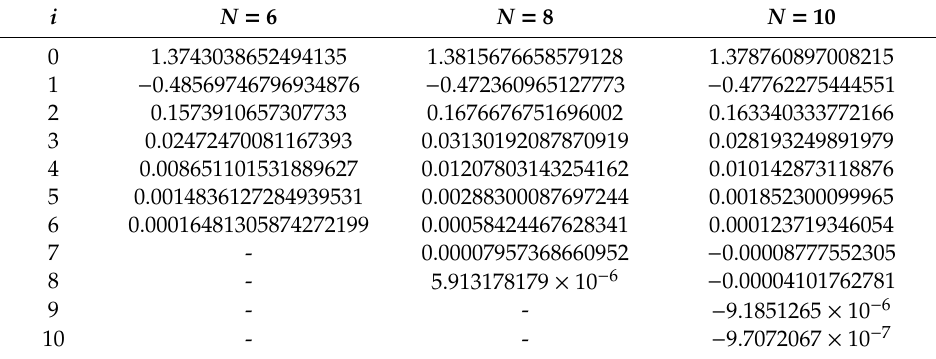
Table 1. The results of rational Chebyshev (RC) coe ffi cients